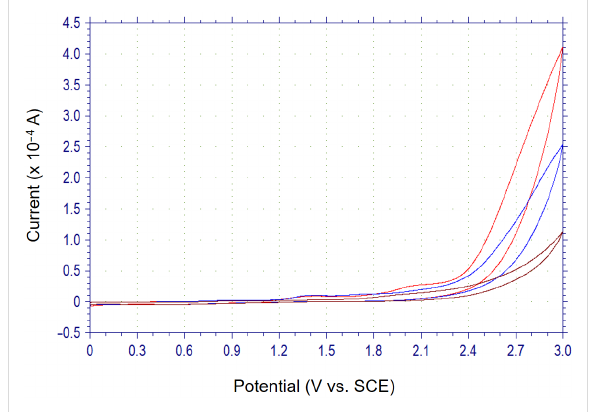
Figure 1: Cyclic voltammograms of 0.1 M Bu 4 NBF 4 /MeCN with a Pt disk working electrode in the absence (brown line) and presence of